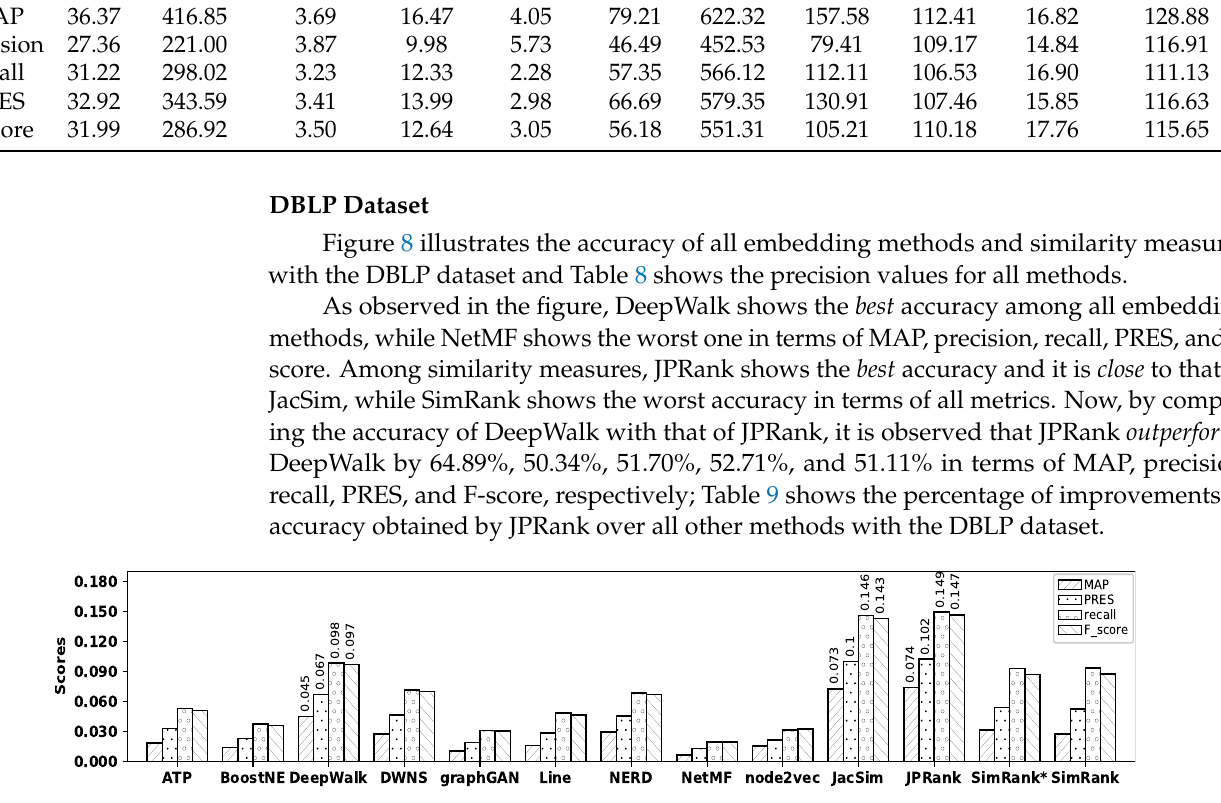
Figure 8. Accuracy of embedding methods and similarity measures with the DBLP dataset. Table 8. Precision values with the DBLP